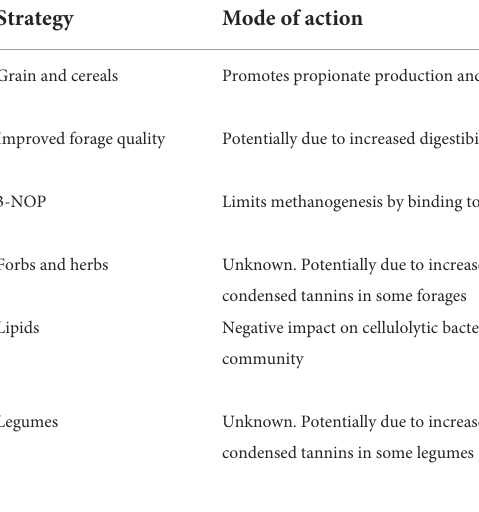
TABLE 2 Description of the antimethanogenic mode of action of dietary-focused methane abatement